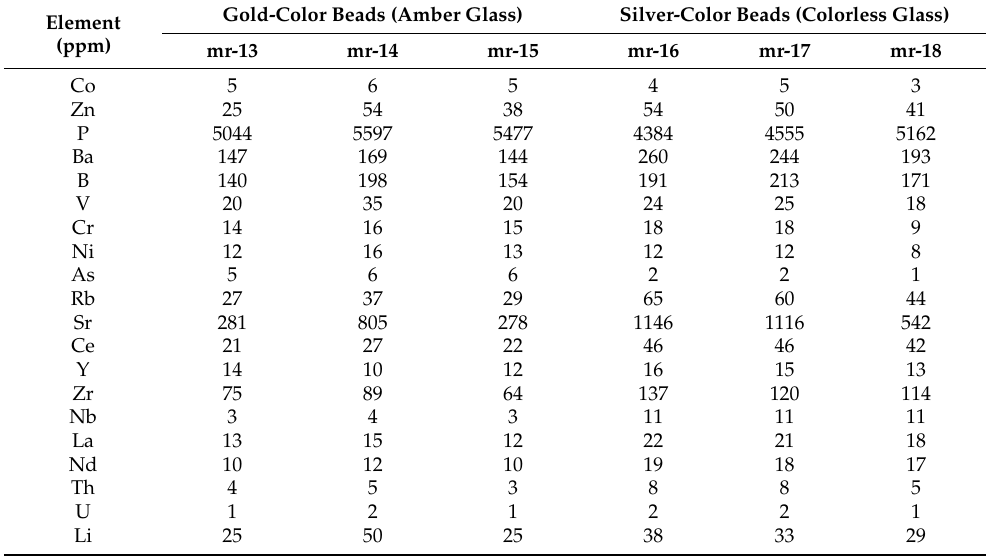
Table 4. LA-ICP-MS analytical results of silver foil glass beads excavated from the tomb of King